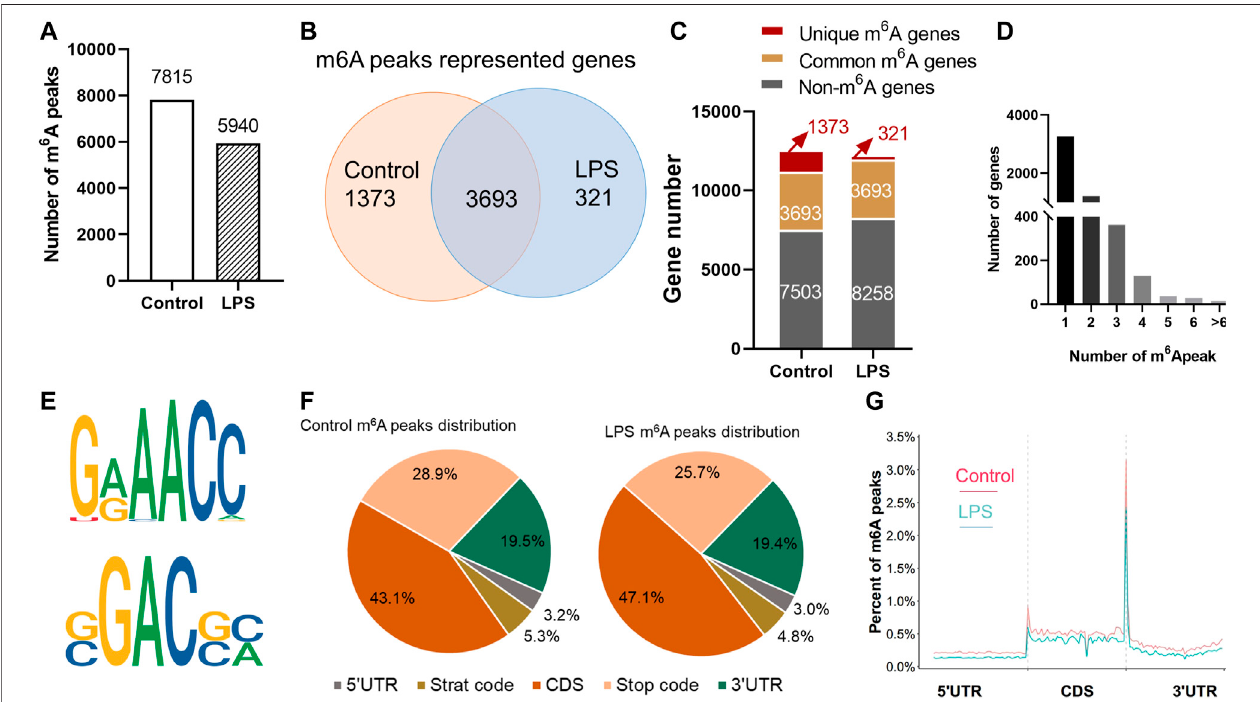
FIGURE 2 | Transcriptome-wide m6 A -Seq of m 6 A peaks in chicken liver. (A) Number of total m 6 A peaks identi fi ed in control and LPS group; (B,C) m 6 A modi fi ed genesincontrolandLPSgroup. (D) Numberofm 6 Apeaksineachmodi fi edgene. (E) Thetopconsensusmotifofthecontrolm 6 Apeaks. (F) Theratioofm 6 Adistribution in different region of the transcripts both in control and LPS group. (G) Distribution of m 6 A peaks across the length of mRNA transcripts. Each transcript is divided into three parts: 5 ′ UTRs, CDs, and 3 ′